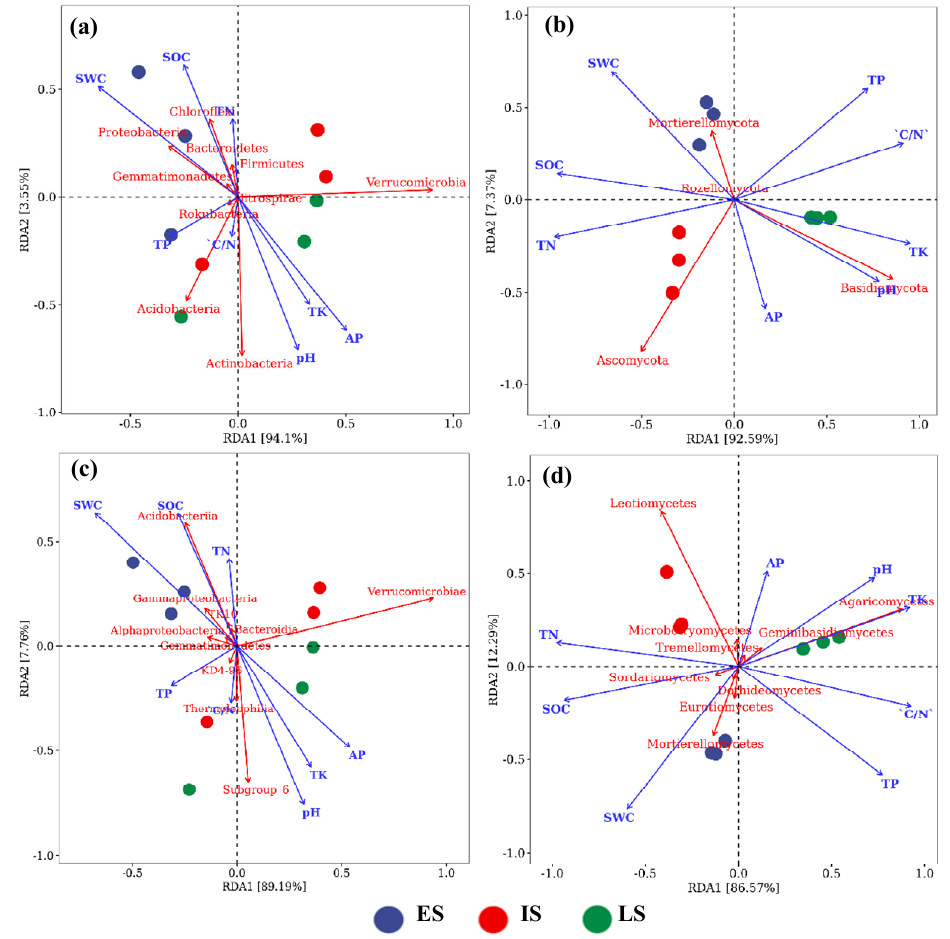
Figure 6. RDA analysis of soil bacterial ( a , c ) and fungal ( b , d ) dominant community composition at phylum ( a , b ) and class ( c , d ) level, and soil properties in the broad-leaved Korean pine forest at different successional stages in Lesser Hinggan Mountains. ES: Early-stage; IS: Intermediate-stage; LS: Late-stage.